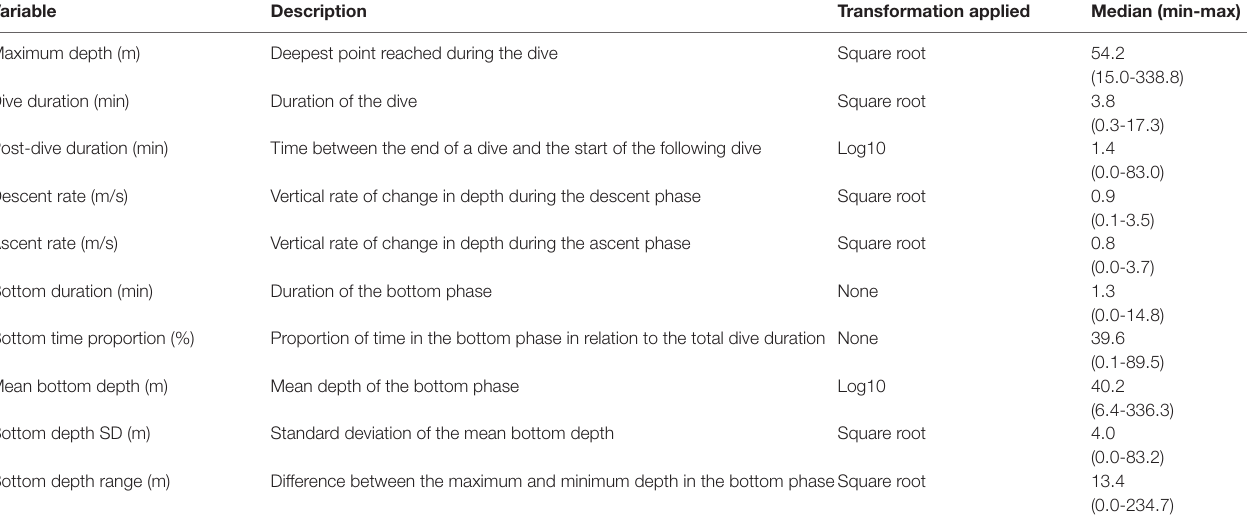
TABLE 1 | Description and summary statistics (median and range) of the dive variables analyzed in this